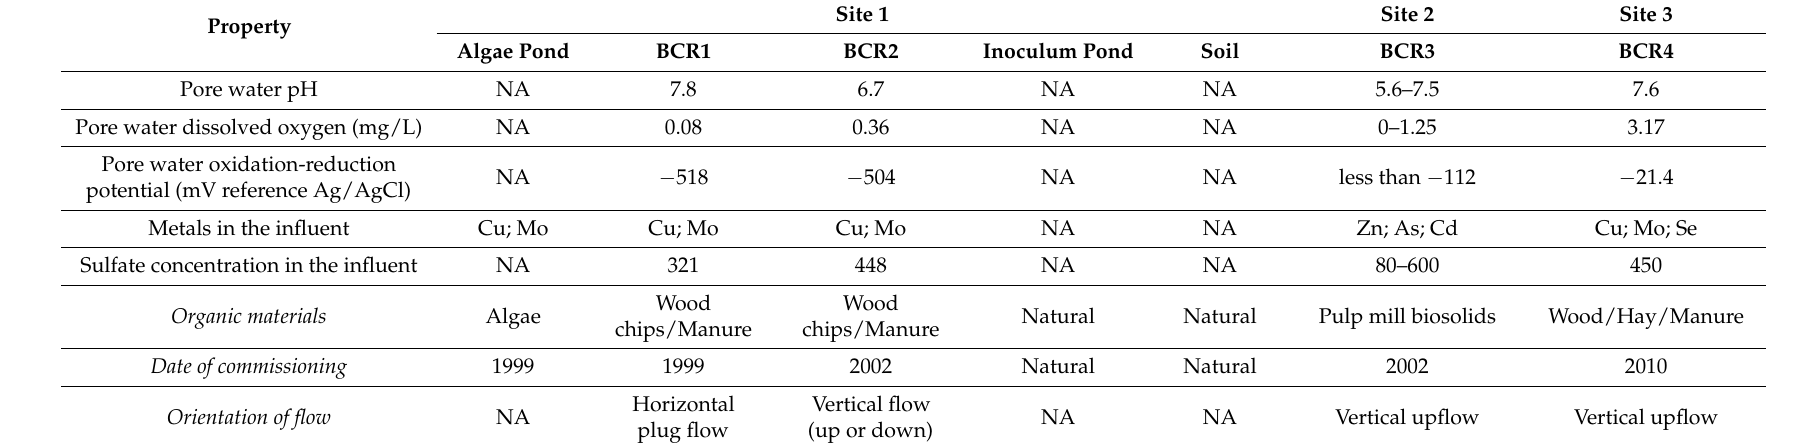
Table 1. Properties of the biochemical reactors (BCRs), algae pond, inoculum pond and soil on the day of sample collection.